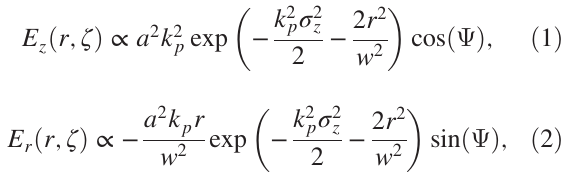
FIG. 1. Beam size (solid black line) and emittance evolution (red line) in the injection section. The dashed line represents the beam size evolution without the plasma target to illustrate the position and size of the virtual electron focus in the injection